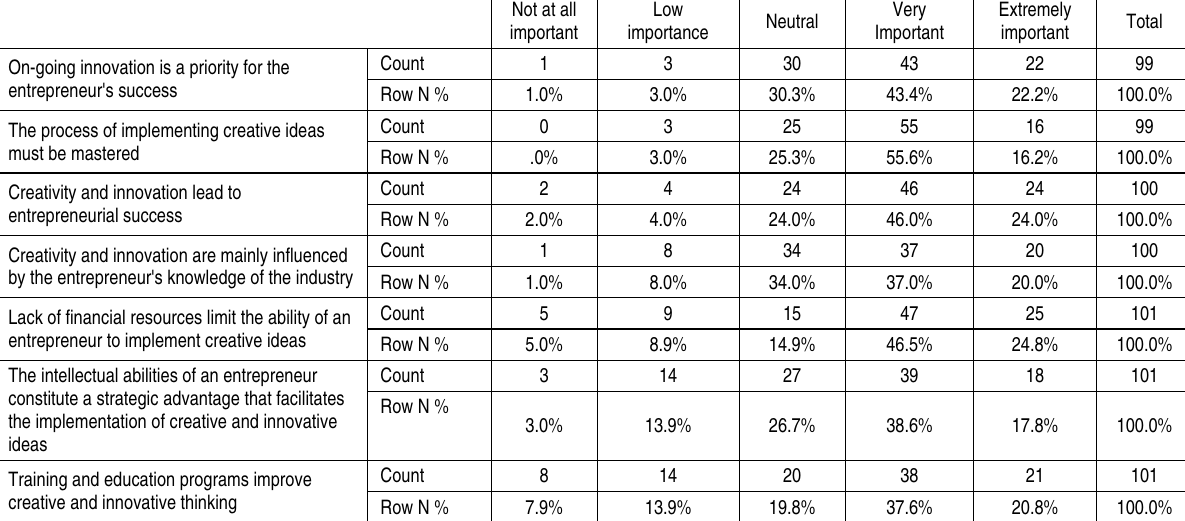
Very Not at all Low Neutral important importance